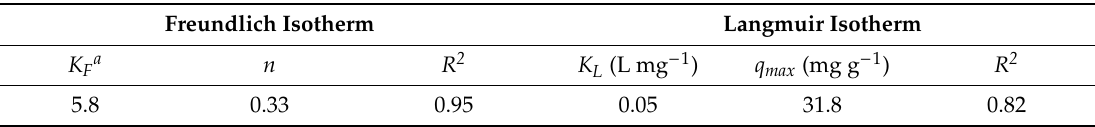
Table 3. Isotherm parameters for fitted Freundlich and Langmuir isotherm models of carbamazepine sorption on BC-Mag. Freundlich Isotherm Langmuir Isotherm K